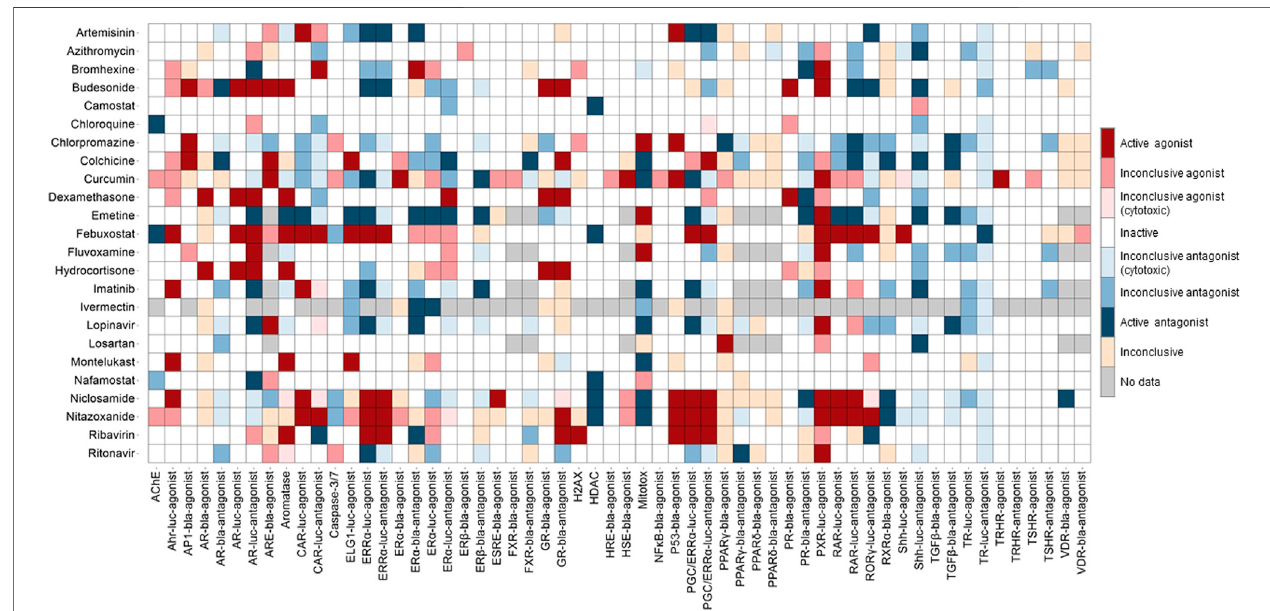
FIGURE 1 | Activity of the drugs from Tox21 screenings. In the heat map, each column is an assay readout and each row is a drug. The heatmap is colored by the activity. The darkest of red and blue indicates the most active agonists and antagonists respectively. The other shades of red and blue indicates the respective inconclusives and in majority of the assays the drugs are